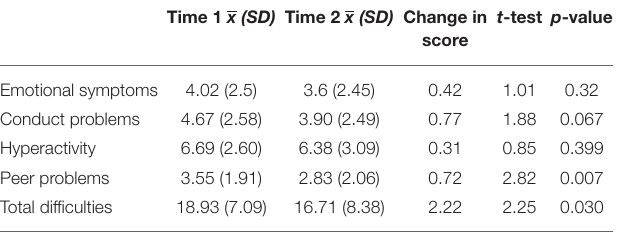
TABLE 8 | Change over time SDQ completed by matched pairs—teachers ( n =